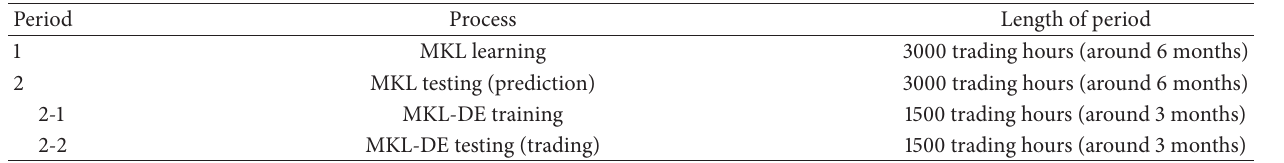
Table 8: Trading and testing periods for MKL and